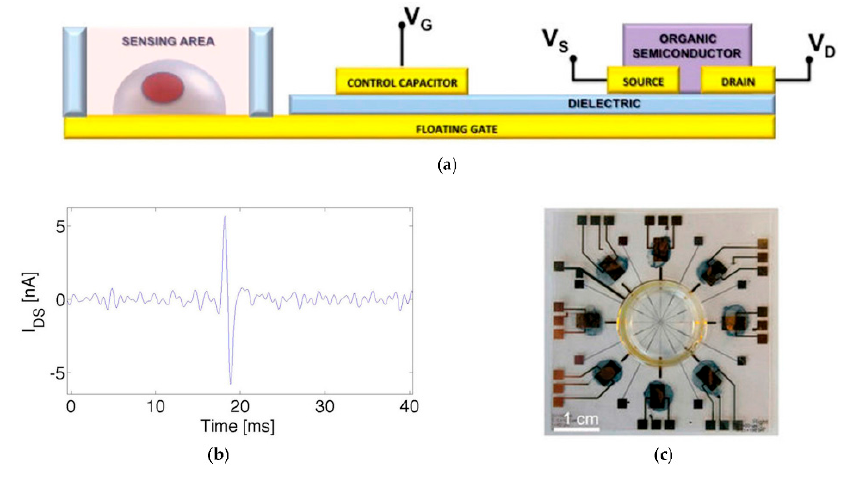
Figure 14. ( a ) Cross section of an OCMFET device; ( b ) Single action potential measured with an OCMFET; ( c ) A complete device with 8 OCMFETs and 8 microelectrodes; in the centre of the